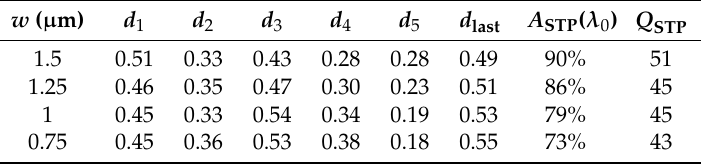
Table 4. Six dielectric layers, analogous to Table